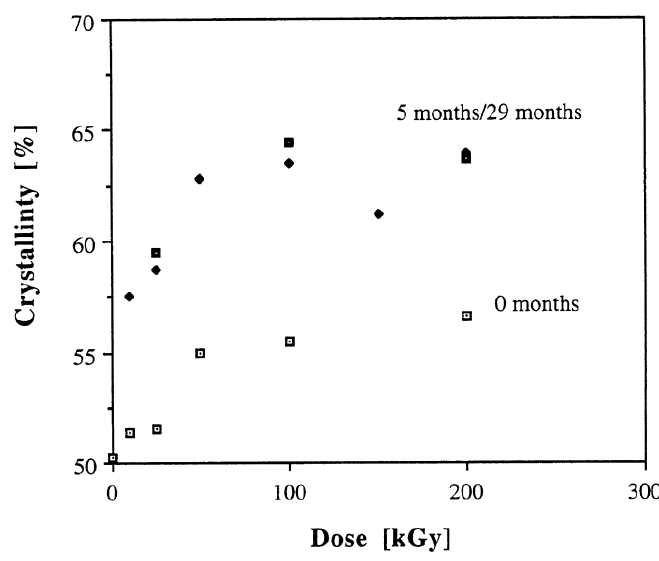
Figure 1. Crystallinity variation with dose and time. Reprinted with permission from [60].